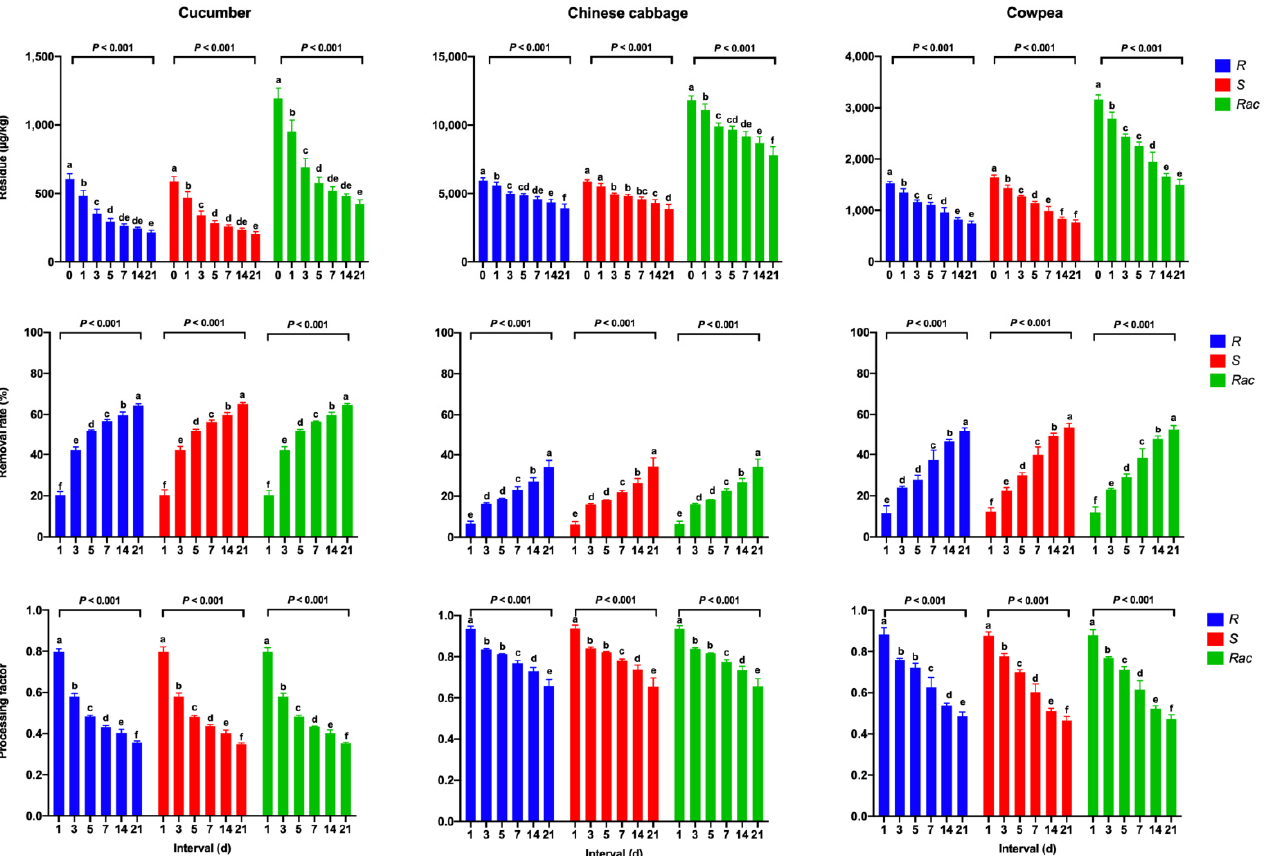
Figure 2. Residues, removal rates (RRs) of mandipropamid enantiomers, and racemate and processing factors (PFs) for different intervals after pickling in cucumber, Chinese cabbage, and cowpea samples. Error bars represent the standard deviation (SD) of triplicates. Each lowercase letter indicates significant differences between the seven sampling intervals ( p ≤ 0.05, Duncan’s multiple range test).